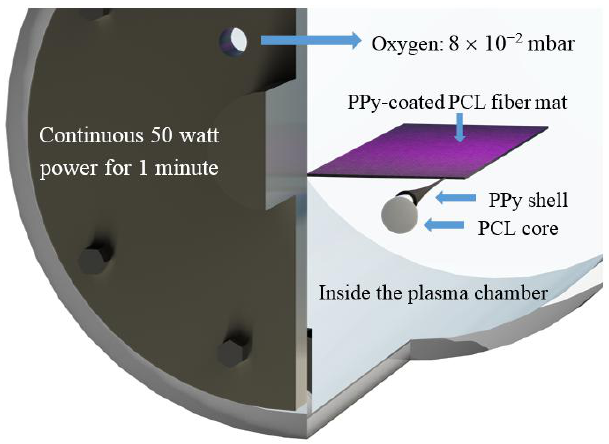
Figure 1. Oxygen plasma treatment of PPy-coated PCL fiber mat conducted in a plasma chamber; PCL: poly(ε-caprolactone); PPy:polypyrrole.